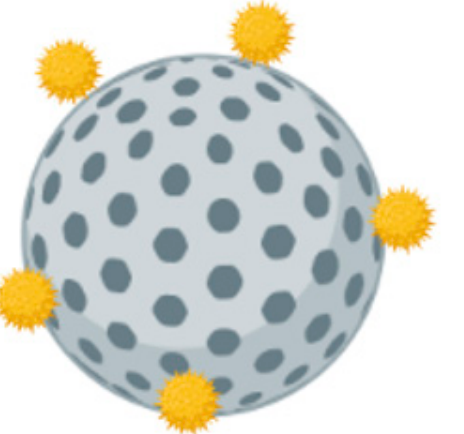
Figure 8. Schematic representation of calcium phosphate nanoparticle adsorbed with antigens. Table 1. Nanoparticle-based vaccines against infectious diseases in clinical trials.